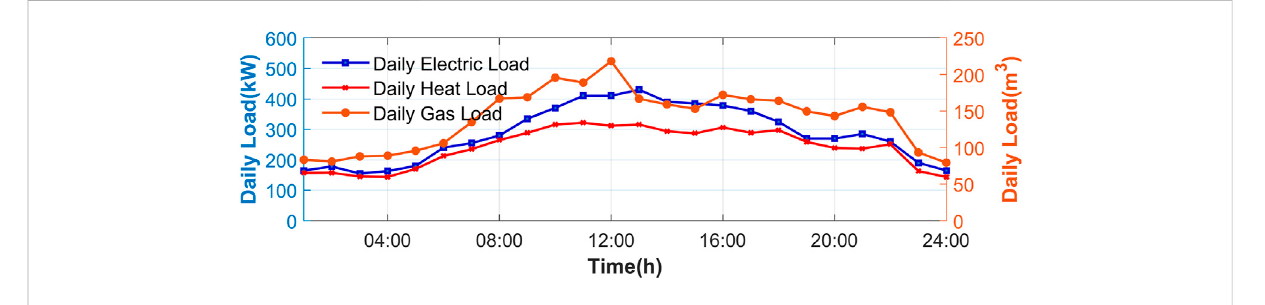
FIGURE 4 Daily load pro fi les of MEMG.